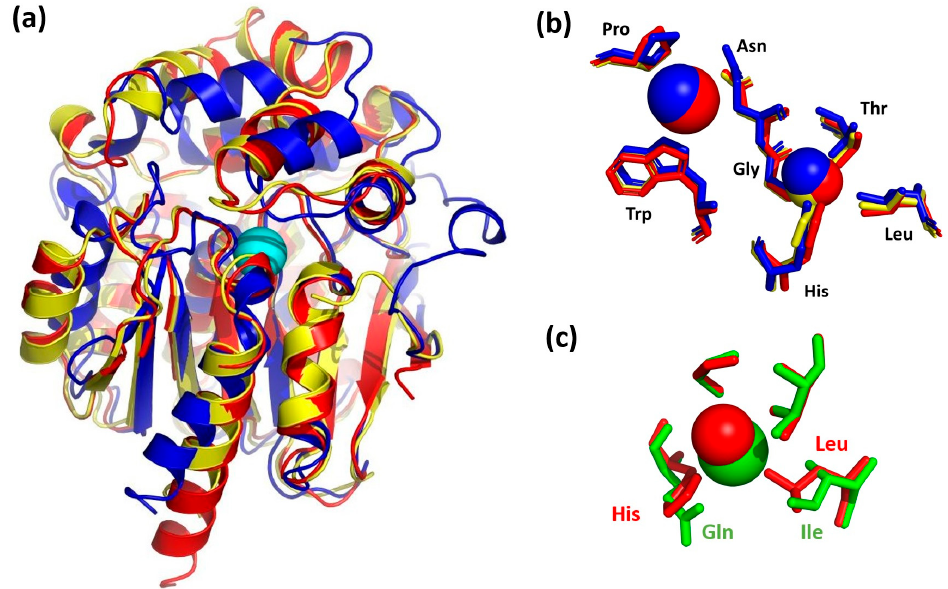
Figure 5. Structural comparison of DbeA ∆ Cl with homologous dehalogenases. ( a ) DbeA ∆ Cl secondary structure superposition with DhaA and DhlA. C α ribbon trace shows elements of the protein secondary structures. The DbeA ∆ Cl is coloured in red; DhaA is coloured in blue; DhlA is shown in yellow; iodide ion (cyan sphere) is placed in the canonical active site of DbeA ∆ Cl. ( b ) Superposition of DbeA ∆ Cl, DhaA and DhlA active sites. Amino acids of DbeA ∆ Cl are shown as red sticks; amino acids of DhaA are shown as blue sticks; amino acids of DhlA are shown as yellow sticks. The iodide ion and water molecule W11 bound to DbeA ∆ Cl are represented as red spheres; bromide ion and water are shown as blue spheres for the DhaA structure and the single water molecule in the DhlA is shown as yellow sphere. (c) Superposition of second halide binding site residues of mutant and wild type DbeA. DbeA ∆ Cl amino acids are shown as red sticks; amino acids of DbeAwt are shown as green sticks. Water W71 is shown as red sphere and Cl − ion is shown as green sphere.